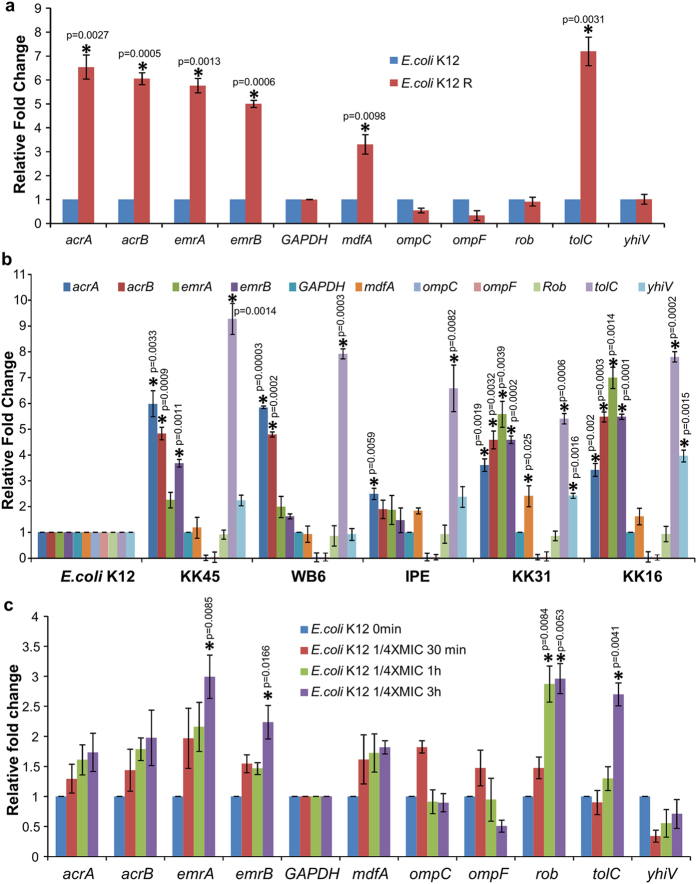
Resistant phenotypes show up-regulated efflux pumps and down-regulated porins.Relative gene expression analysis (a) E. coli K12 (control) and de novo generated PPEF resistant E. coli K12 measured by qPCR. (b) E. coli K12 (control) and MDR E. coli isolates (c) E. coli K12 (control) and E. coli K12 treated with ¼ XMIC PPEF for 30 mins, 1 h and 3 h. Results are presented as mean ± SD of three independent experiments (n = 3). Statistical comparison between control and experimental conditions were found to be statistically significant with *p < 0.01. Detailed statistically significant p-values of control vs. experimental are indicated.